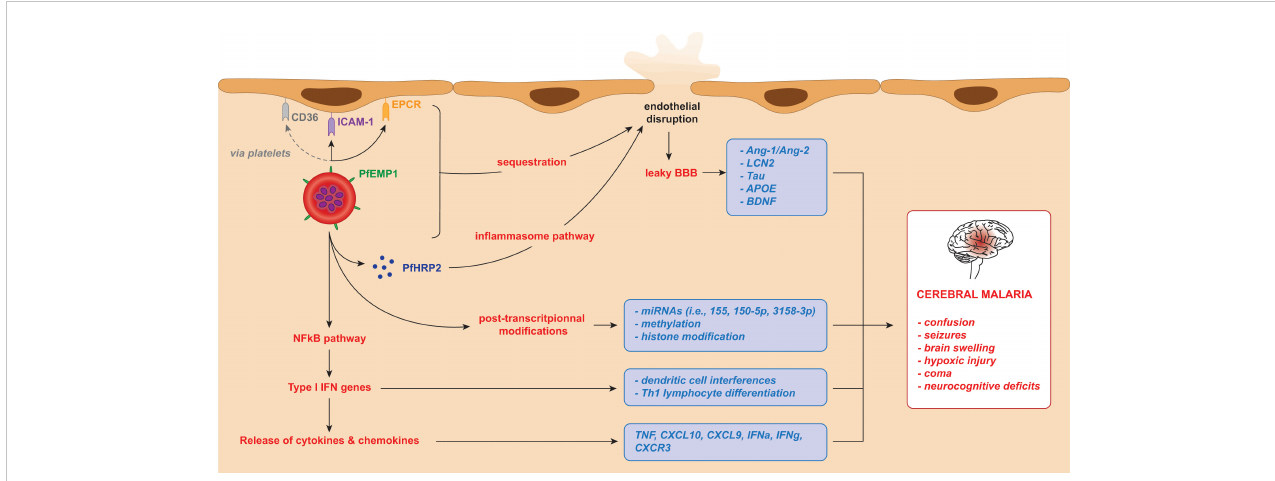
FIGURE 1 iRBC adhesion and subsequent release of potential biomarkers for cerebral malaria in Plasmodium falciparum infection. The cytoadherence of infected red blood cells triggers the release of parasitic and host components leading to a cascade of in fl ammatory mechanisms. In turn, these result in brain microvasculature endothelial disruption and clinical manifestations of cerebral malaria. These factors, listed in the blue boxes, can be considered as biomarkers of cerebral